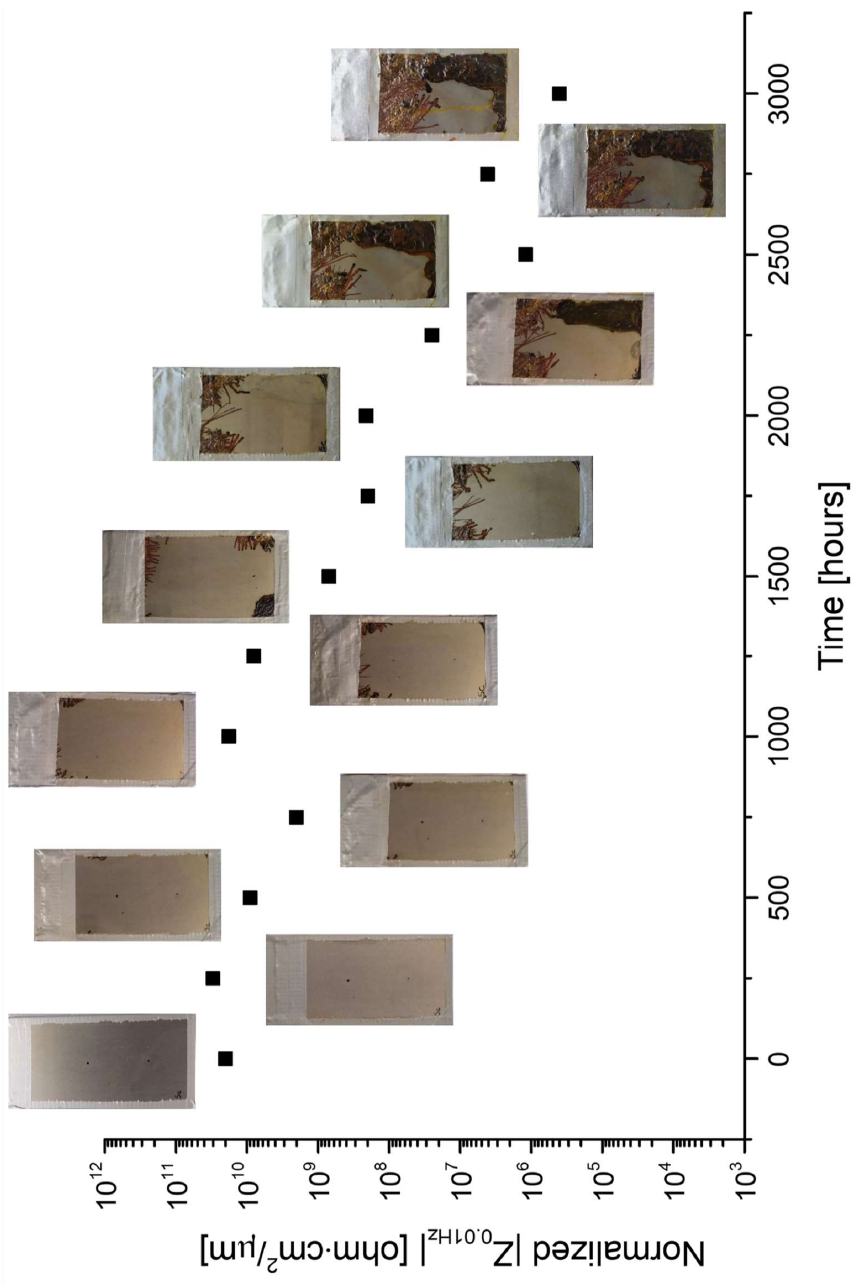
Figure 12. Example of impedance modulus evolution in time and the corresponding corrosion evolution during the prohesion test for painted steel.